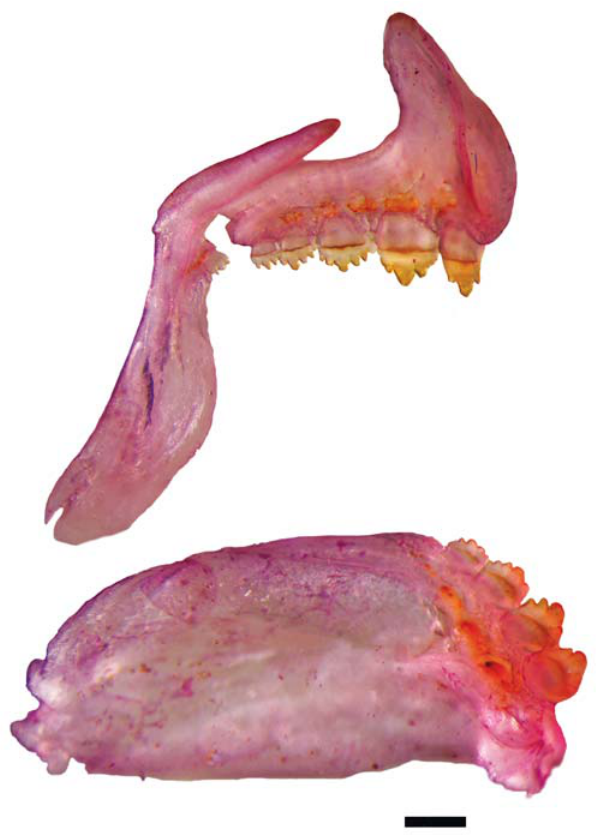
Fig. 5. Astyanax erythropterus , AI 265, 84.7 mm SL: left premaxilla, maxilla, and lower jaw, internal view. Scale bar = 1 mm.